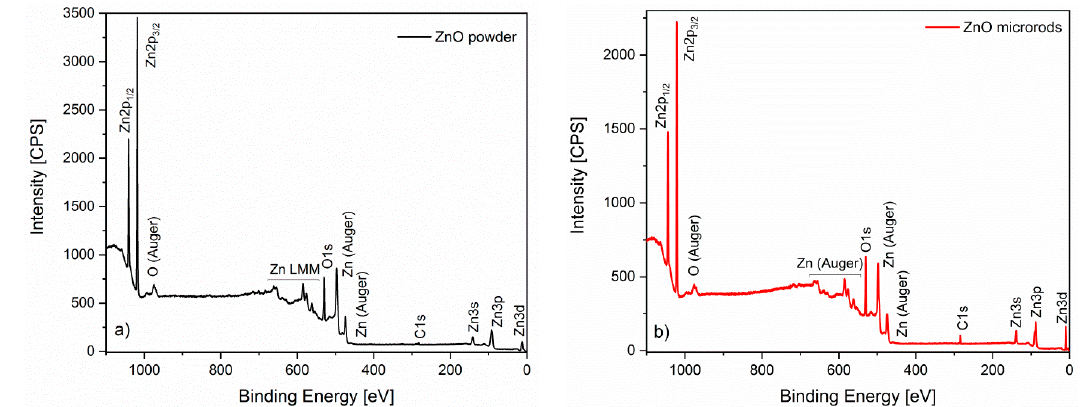
Figure 5. Zinc oxide XPS spectra in the form of: ( a ) powder; ( b ) microrods.